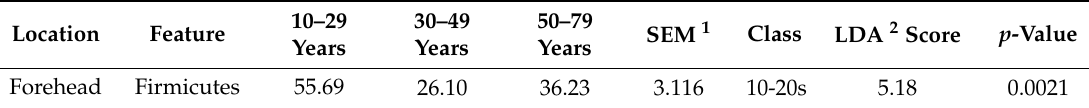
Table 2. Linearly affected major classified taxa by age grouping.